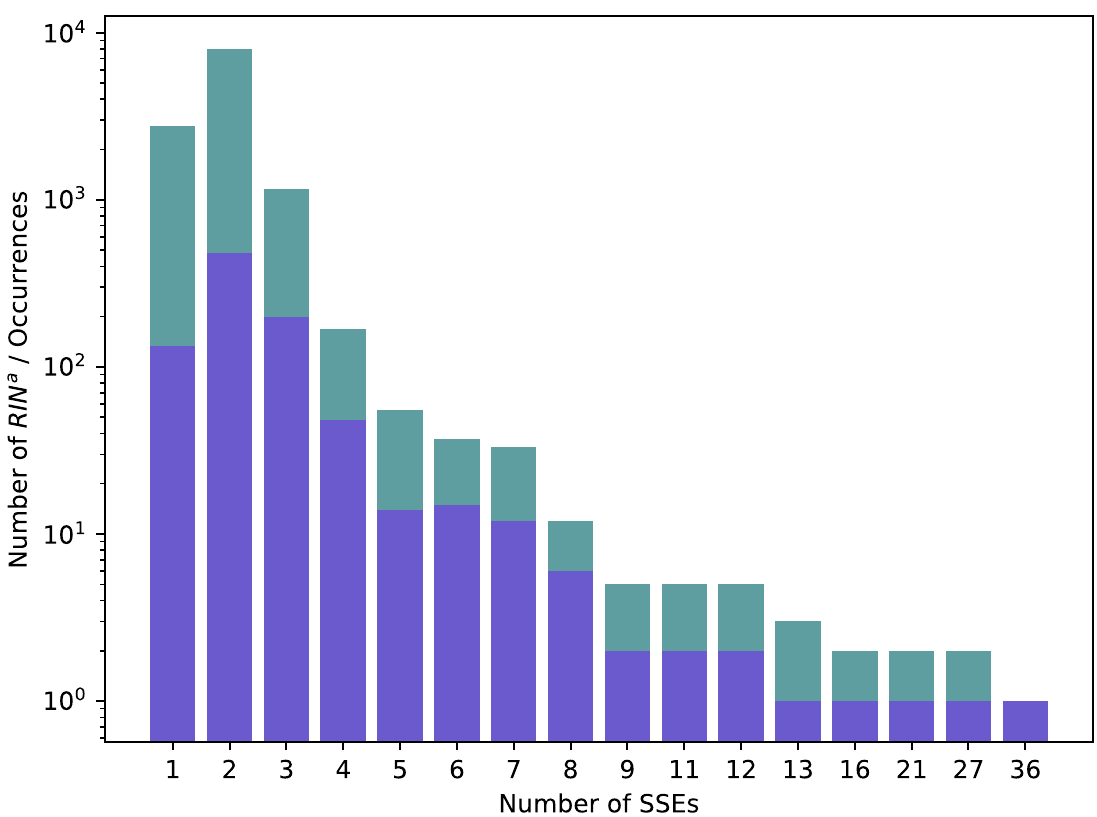
Fig 10. Distribution of RIN a . Numbers of distinct RIN a (in blue) and all their occurrences (in green) over the different numbers of SSEs s s they span over in Dataset 2.92.